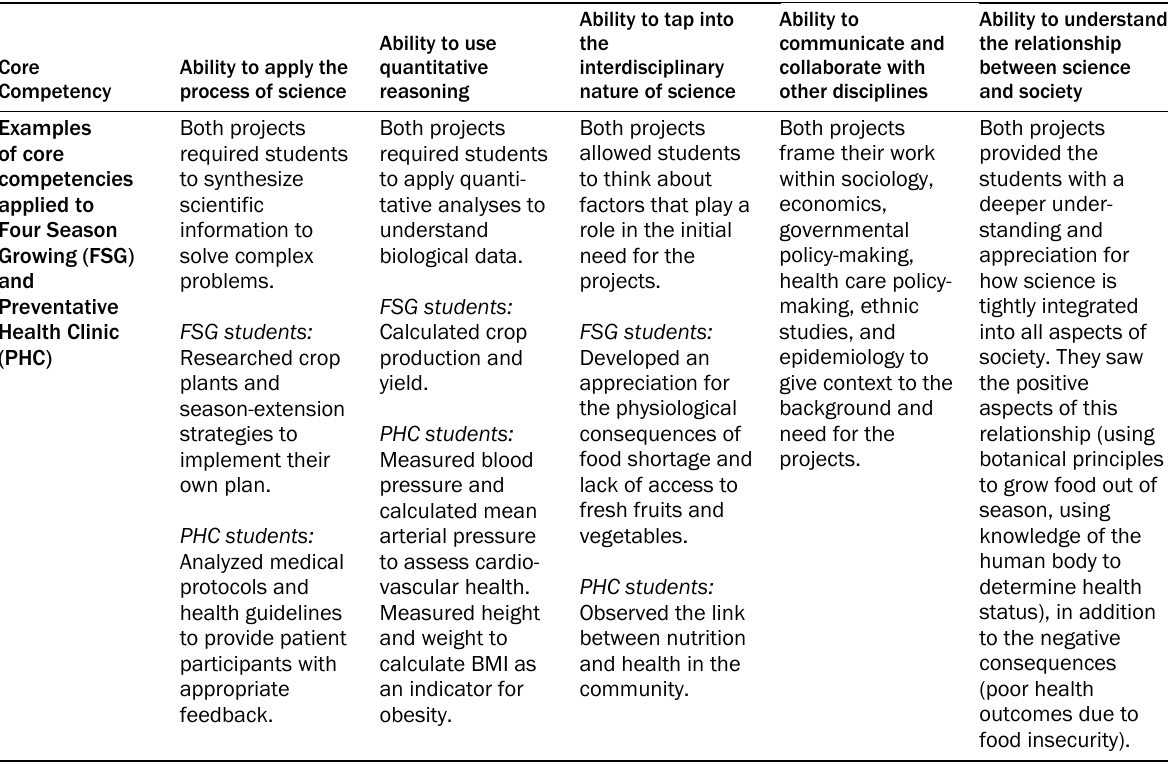
Table 1. NSF Core Competencies and Disciplinary